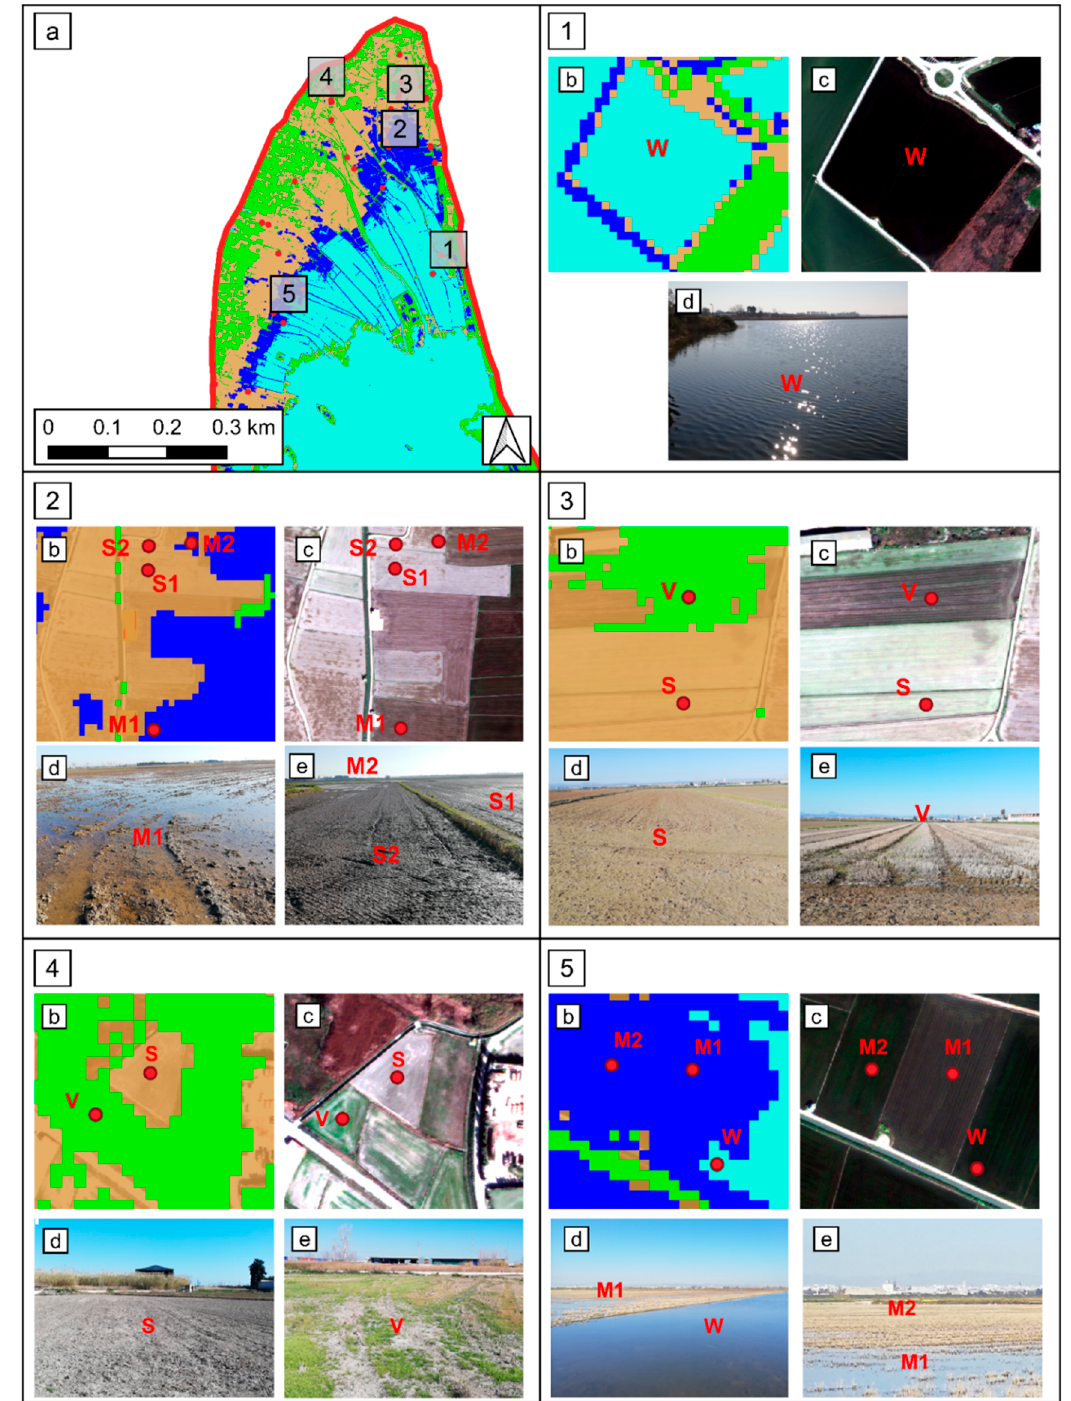
Figure 6. ( a ) Land cover classification extracted by S2 image of 15 February 2020 with field survey locations of 14 February (points) and the position of the frames displayed with larger scales in the panels 1,2 3, 4 and 5; ( b ) zoom of land cover classification; ( c ) zoom of the RGB GeoEye-1 (© TPMO 2020) of 14 February; ( d , e ) ground pictures taken on 14 February.